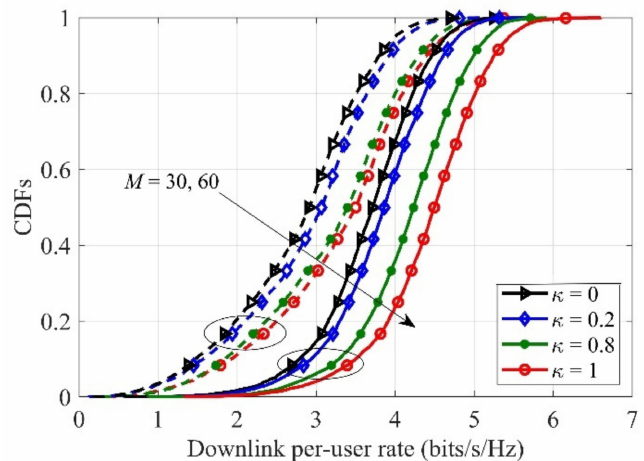
Figure 3. Cumulative distribution functions (CDFs) of the downlink per-user rate for different users, with K = 10, N =